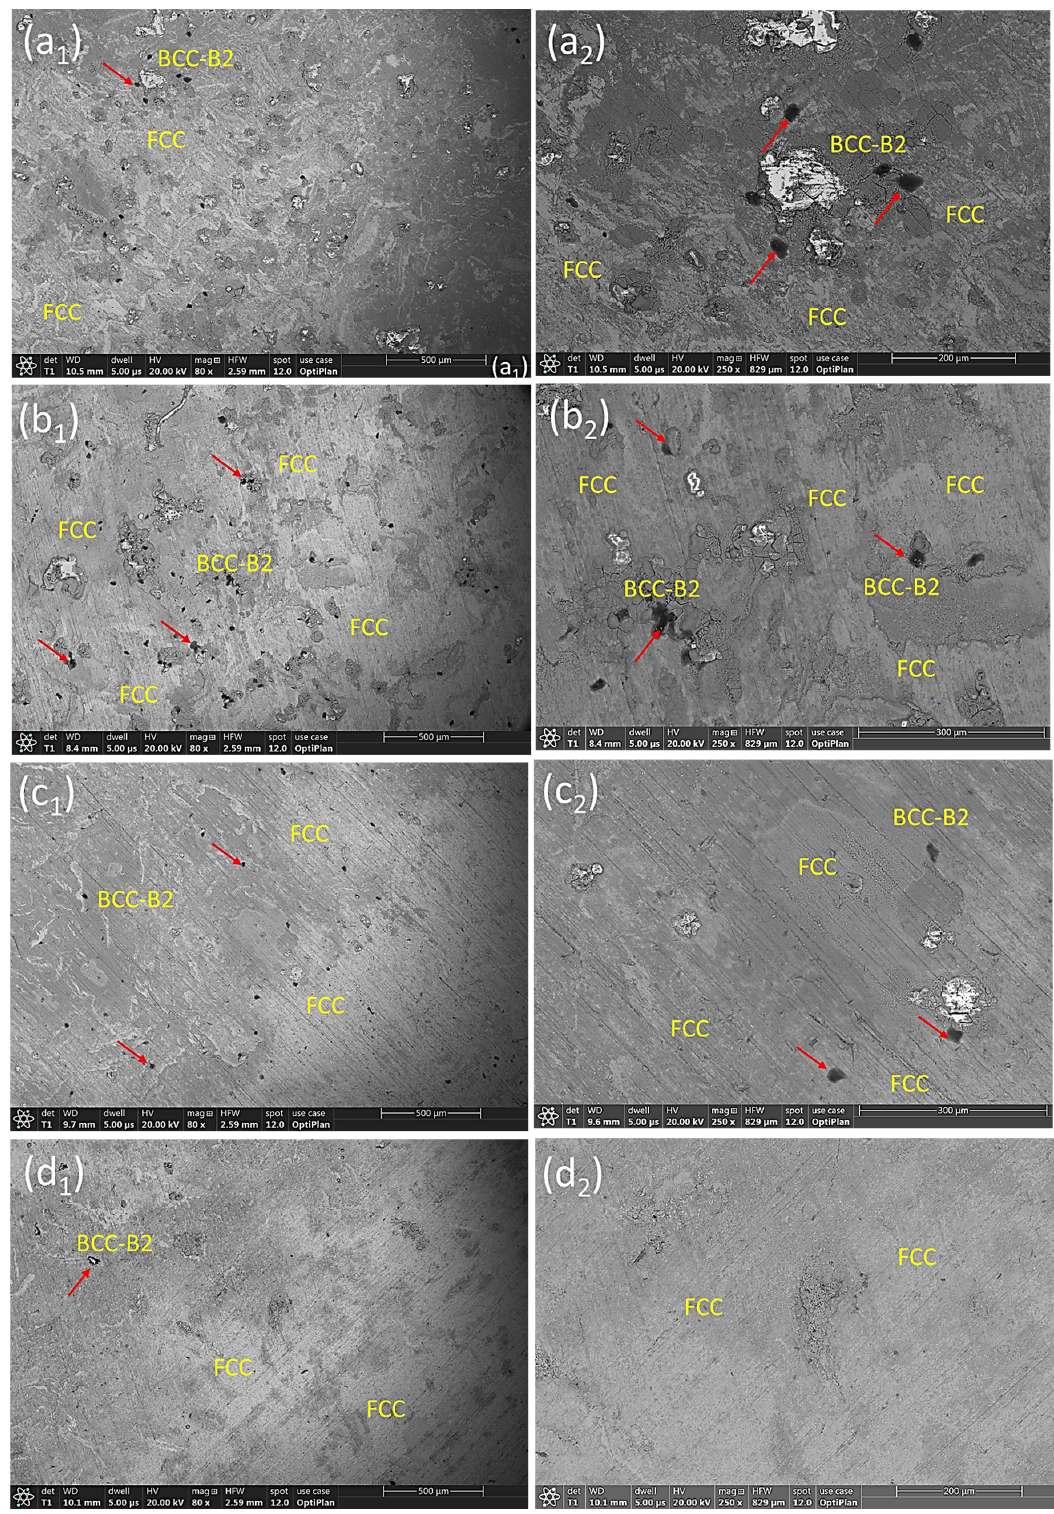
Figure 16. HRSEM surface morphology of corroded samples for the fabricated ODS-HECs at low ( left ) and high ( right ) magnifications: ( a 1 , a 2 ) CrFeCuMnNi; ( b 1 , b 2 ) CrFeCuMnNi-3 vol.% Al 2 O 3 ; ( c 1 , c 2 ) CrFeCuMnNi-3 vol. % Y 2 O 3 ; and ( d 1 , d 2 ) CrFeCuMnNi-3 vol.% TiO 2 . (Red arrow indicate the formation of pits)